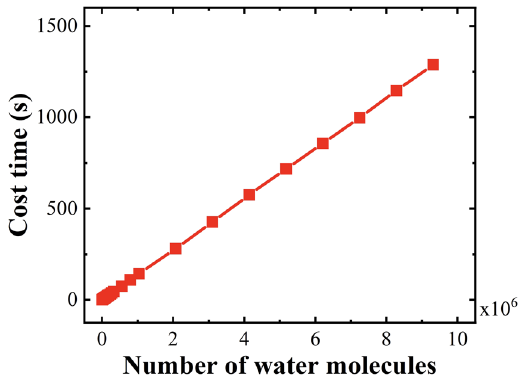
Figure 5: Cage recognition cost time by HTR algorithm as a function of block size ( system: 5 × 8 × 10 sI - type clathrate hydrate, 18,400 water molecules ) .